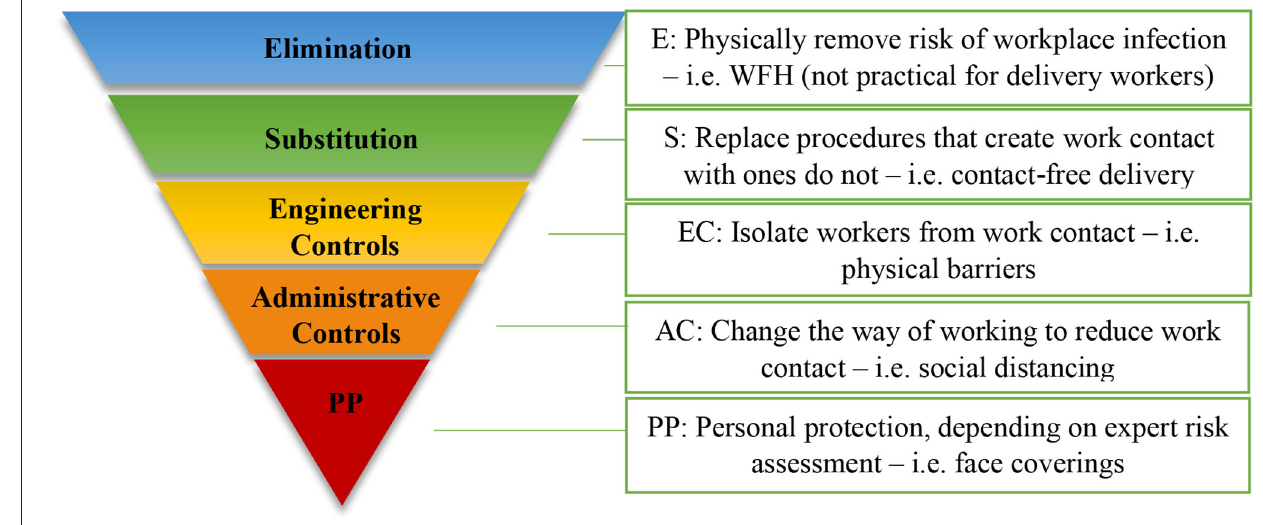
FIGURE 1 | HoC: COVID-19 – Delivery workers (adapted from HSE websites 1